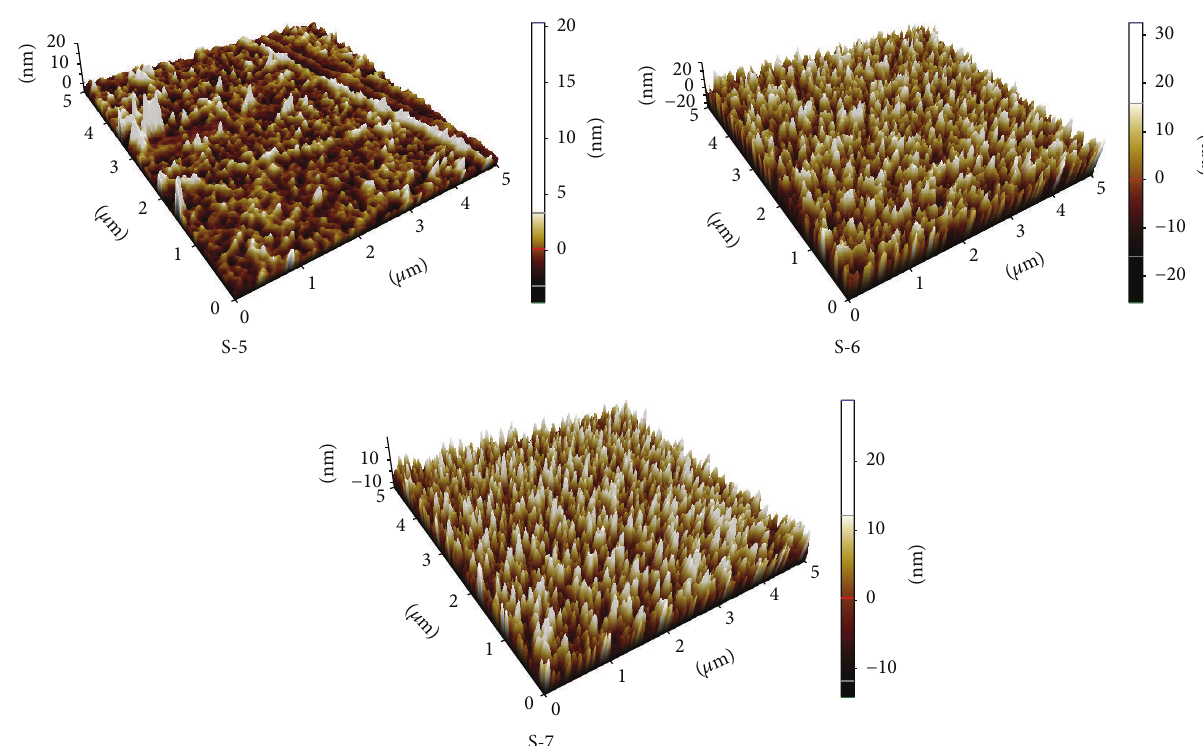
Figure 6: AFM image of the Al-doped CdO thin films of S-5, S-6, and S-7 groups.